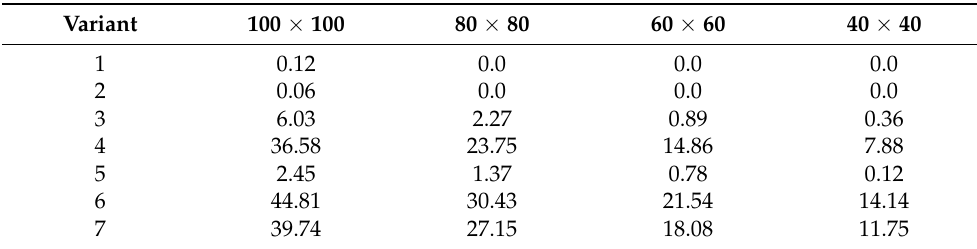
Table 2. Percentage of image frames discarded due to failure to meet the region of interest (ROI) ex- traction condition depending on the ROI size. This condition means that the ROI must be completely contained in the flame